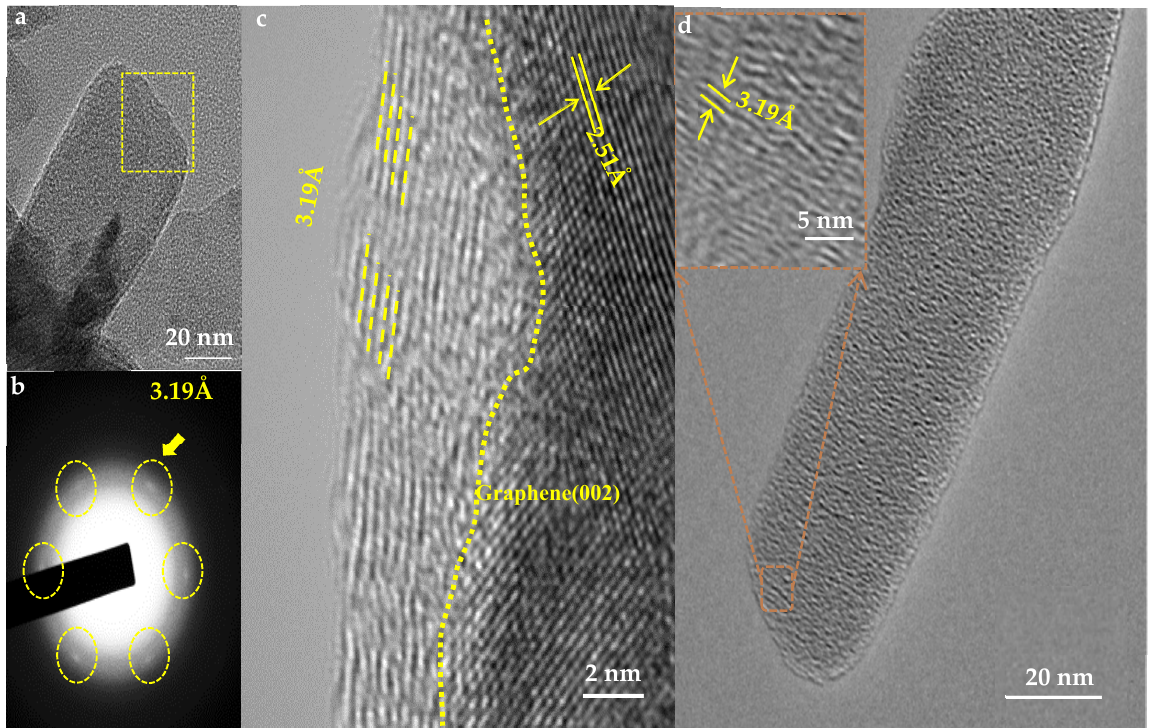
Figure 4. ( a ) TEM image and ( b ) SAED pattern of the yellow dashed region in ( a ) for Fe–N–C-r catalyst; ( c ) HRTEM image of Fe–N–C-r catalyst; ( d ) HRTEM images of Fe–N–C-f catalyst (the inset is the amplified view).